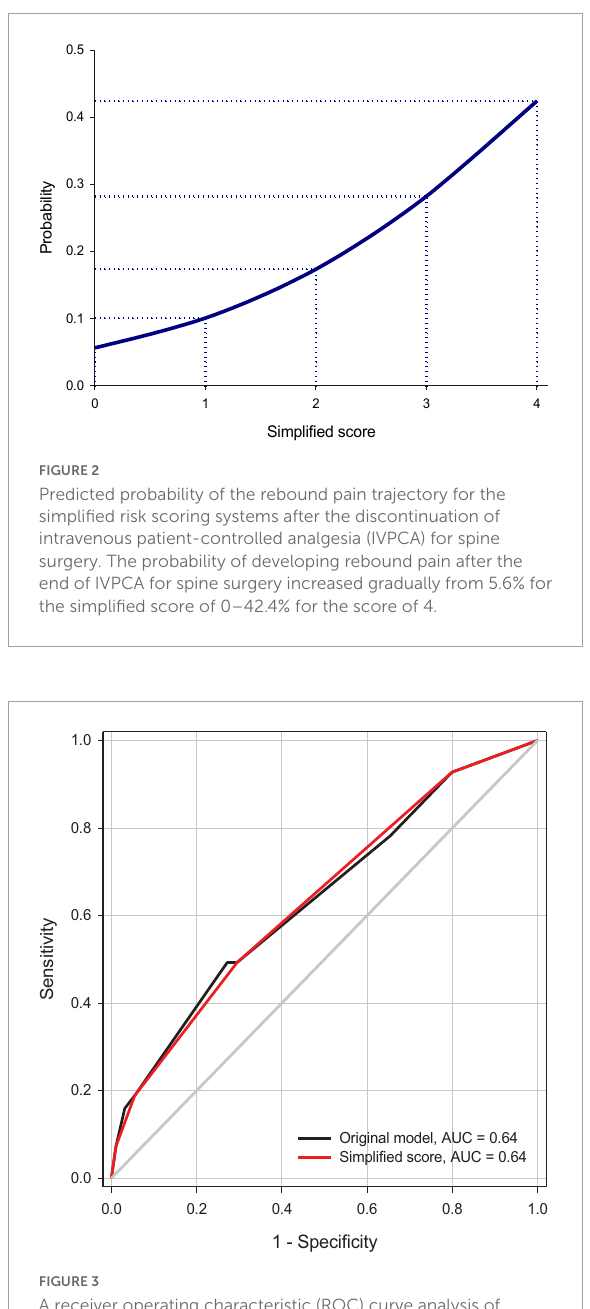
FIGURE3 A receiver operating characteristic (ROC) curve analysis of predictors of increased morphine predictive power for the selected model and the simplified risk scoring system for the rebound pain trajectory. AUC, area under ROC TABLE 2 Risk factors of rebound pain trajectory after the discontinuation of IVPCA following spine surgery. β SE ( β ) OR 95% CI p Simplified risk score Age ≤ 65 vs. > 65 Sex (women vs. men) 0.82